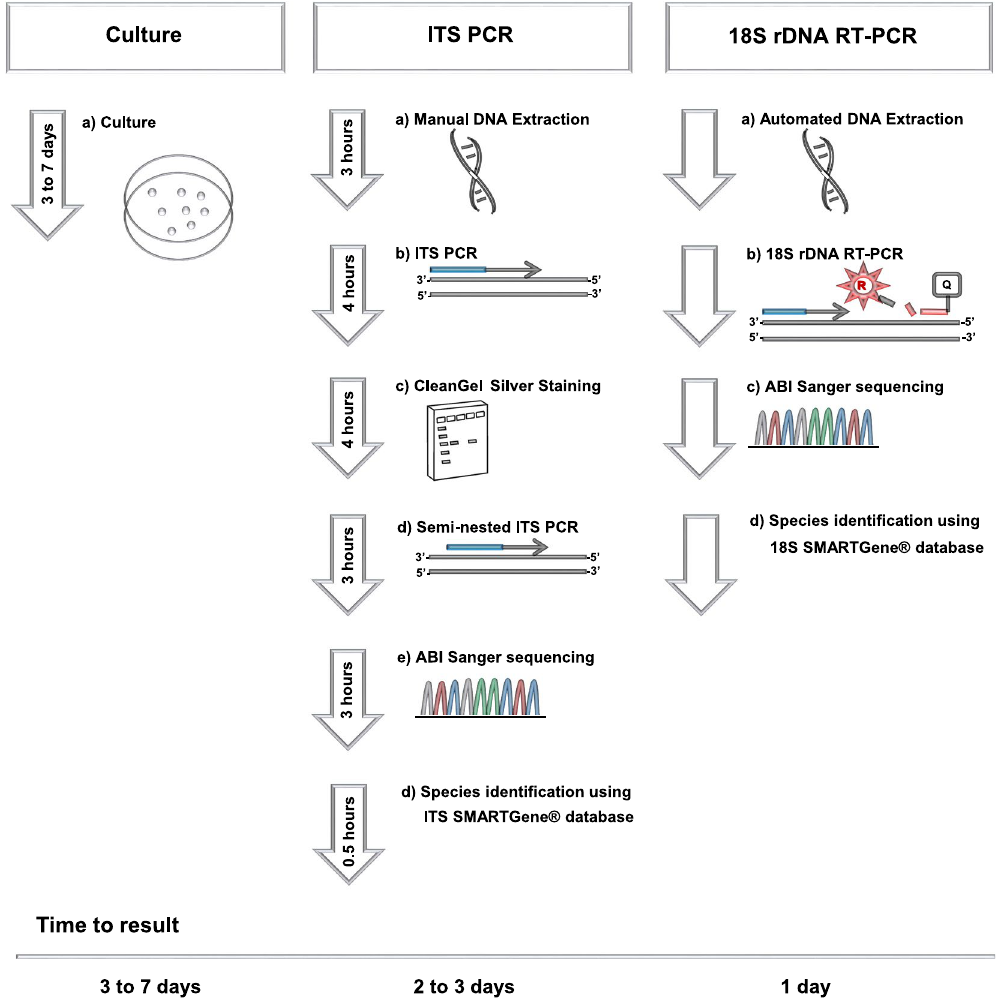
Figure 1. Overview of the diagnostic algorithms used for identification of fungal pathogens at the Institute of Medical Microbiology, University of Zurich.